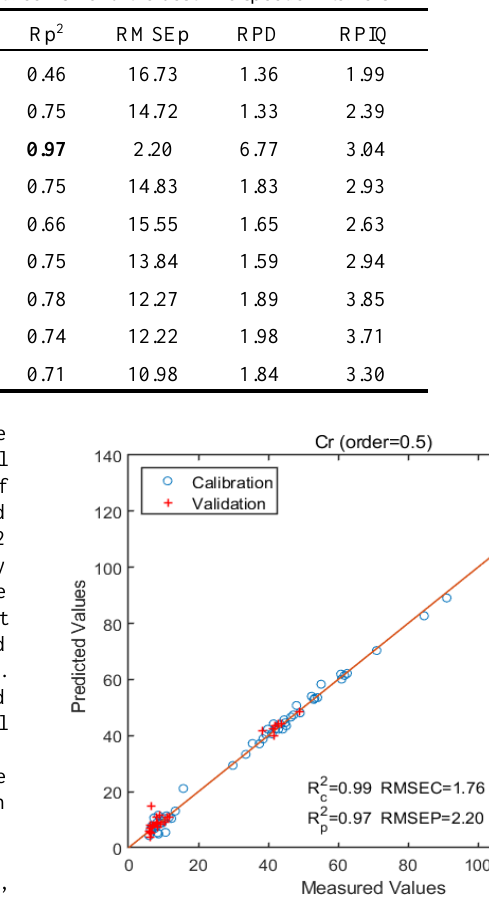
Figure 3. The scatter plot of estimating Cr with five band regions when fractional order = 0.5 (Unit: